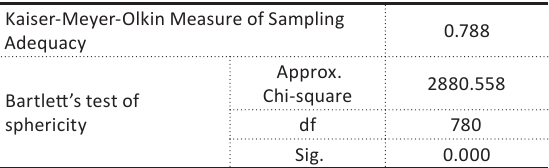
Table 2. KMO and Bartlett’s test